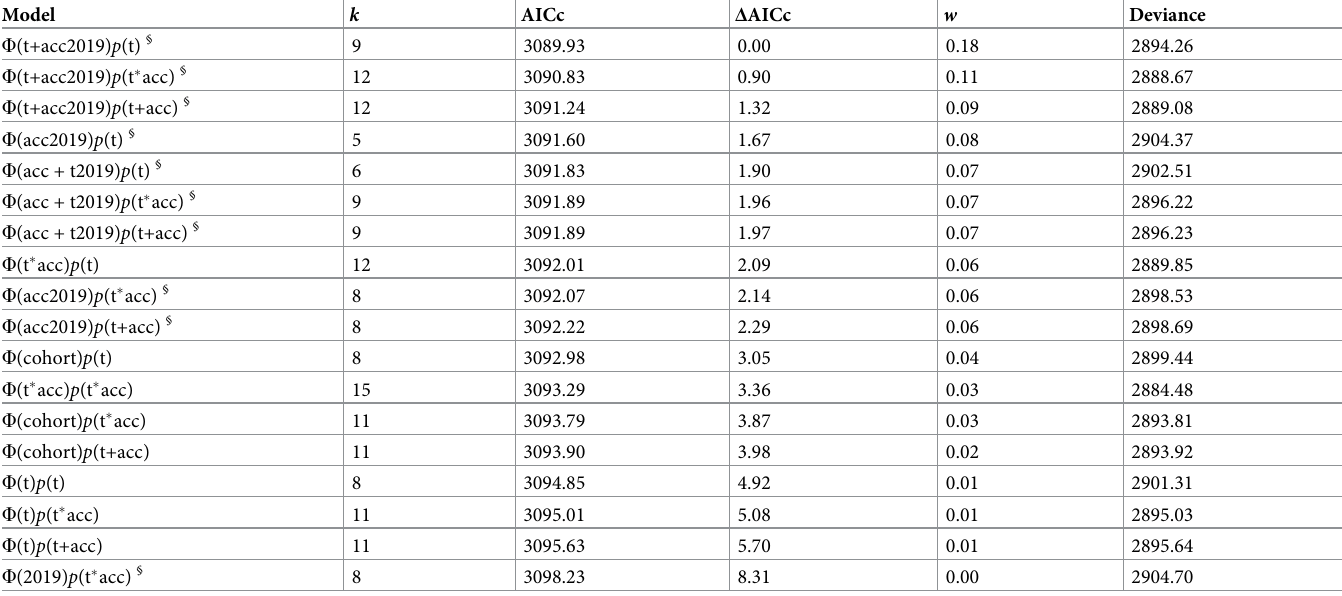
Table 2. Summary of Jolly-Seber POPAN model ranking. F and p refer to apparent survival and recapture probabilities, respectively for Blanding’s Turtles in the Rouge National Urban Park. ‘acc’ refers to the effect of acclimation with two levels: newly released headstarted turtles and those in their first year following release.